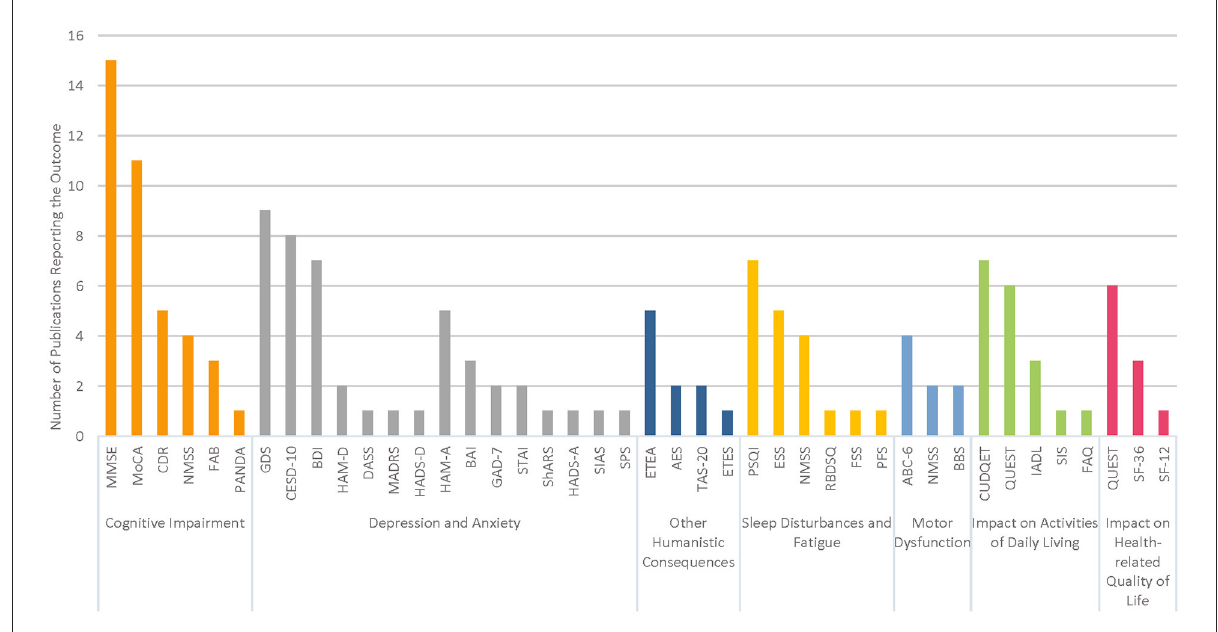
FIGURE2 Summary of structured instruments reported for each outcome